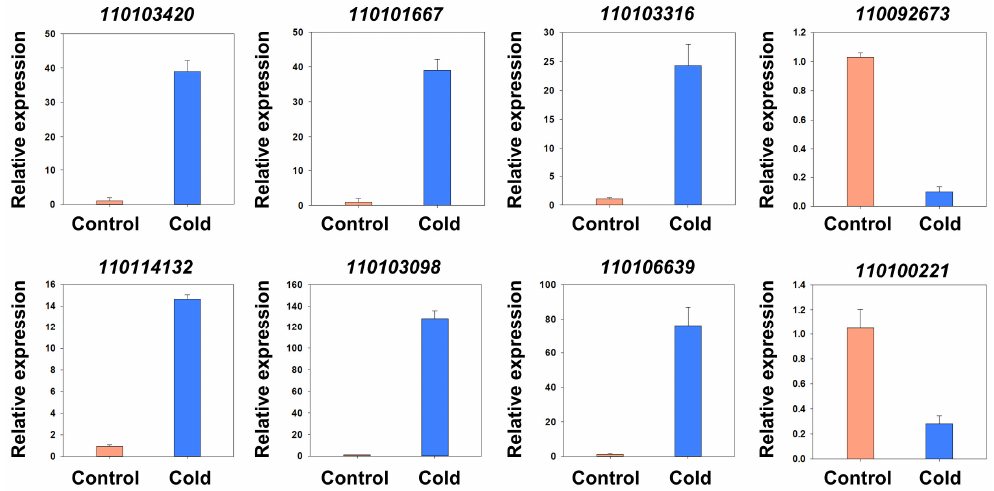
Figure 4. RT–qPCR validation of candidate differentially expressed genes linked to cold resistance in D. catenatum . Data are the mean ± SD of three independent biological replicates.